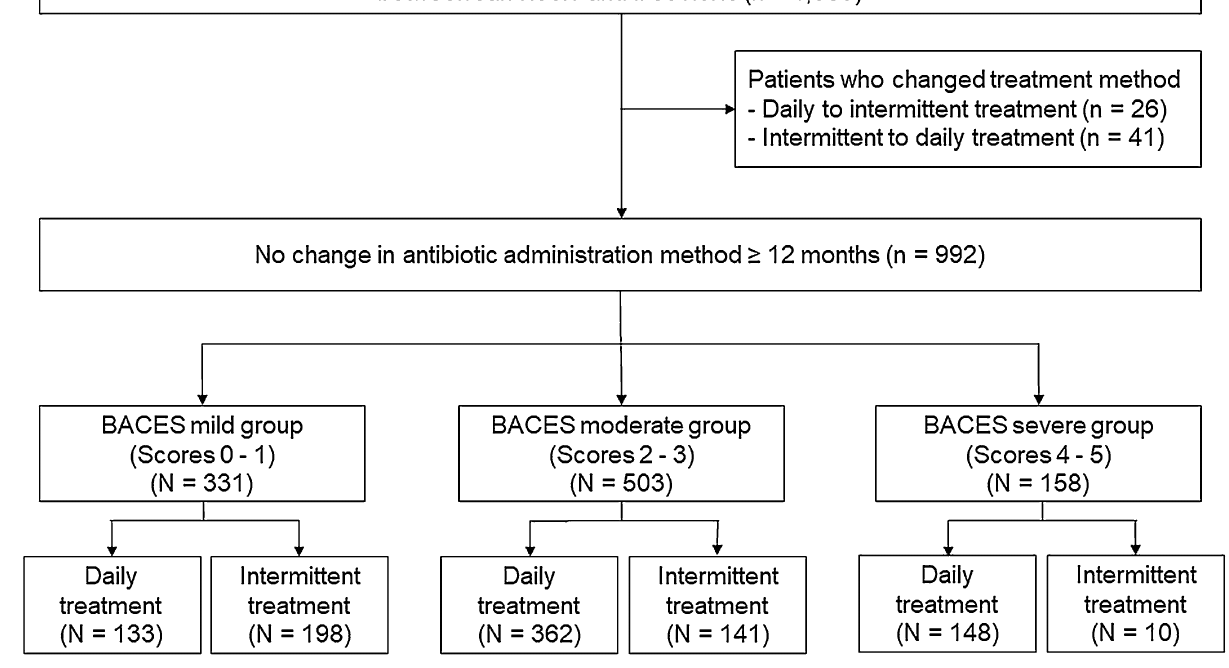
Figure 1. Study patients. Abbreviations: NB, nodular bronchiectatic; FC, fibrocavitary; BACES, BMI, age, cavity, ESR, and sex; BMI, body mass